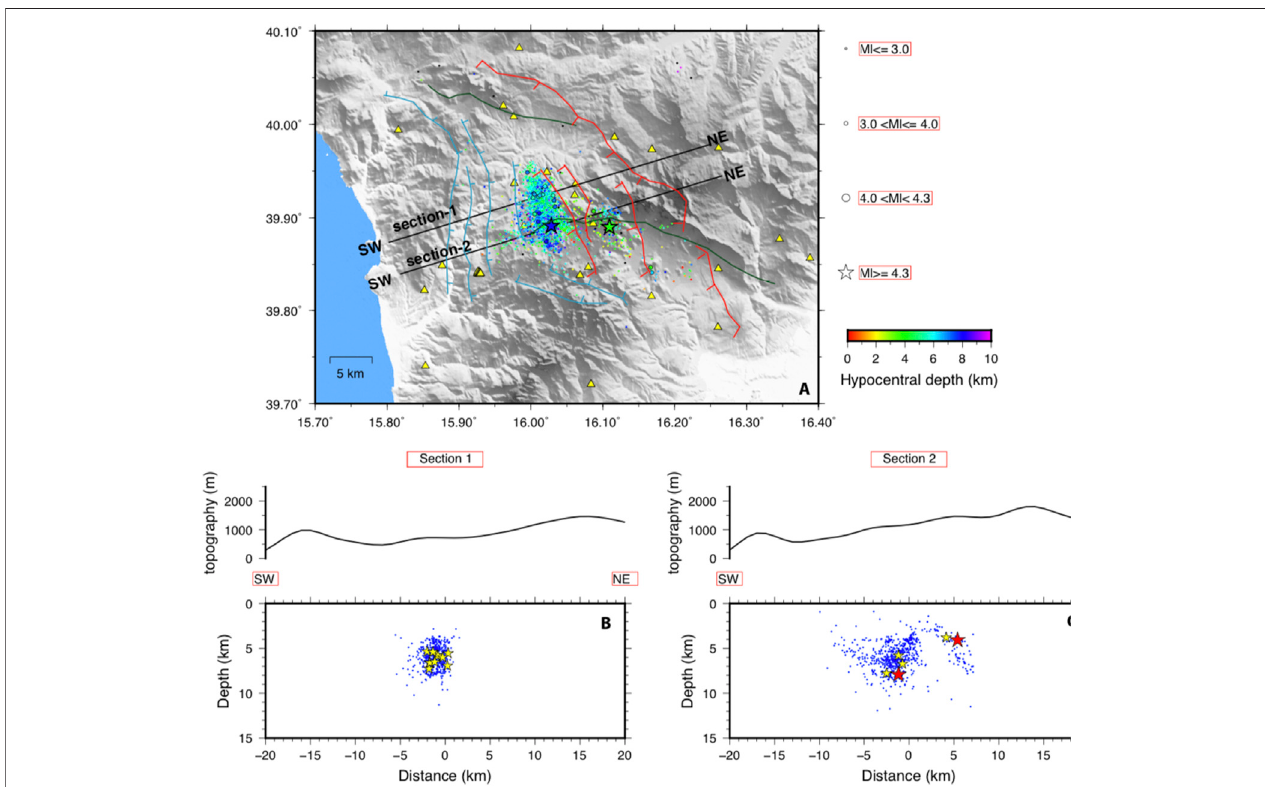
FIGURE 7 | Map and cross sections view of the earthquakes relocated using the minimum 1-D model (A) The top image shows a map of the epicenters, where earthquakes are sized by magnitude according to the symbols on the right of the map and color-coded by hypocentral depth according to the scale on bottom. The M L 5.0 and M L 4.3 mainshocks are represented by stars. Yellow triangles are permanent and temporary seismic stations. Black lines are the traces of the vertical cross- sections. See Figure 1A for major structures description. Two main clusters are recognized: the fi rst one to the West and the other on the East, which include the M L 5.0and M L 4.3events,respectively (B,C) Onthecrosssections-1,and-2,weprojectalltheeventslocatedwithin1 kmfromtheverticalplane. (B) Thehypocenters, in section-1, in the northern part of the sequence, depict a ball-shaped seismogenic volume. (C) The hypocenters, in section-2, on the south, seem to delineate three seismogenic faults. On both the cross sections, the M L 5.0 and M L 4.3 mainshocks are represented by the red stars while the yellow stars identify epicenters with a magnitude larger than